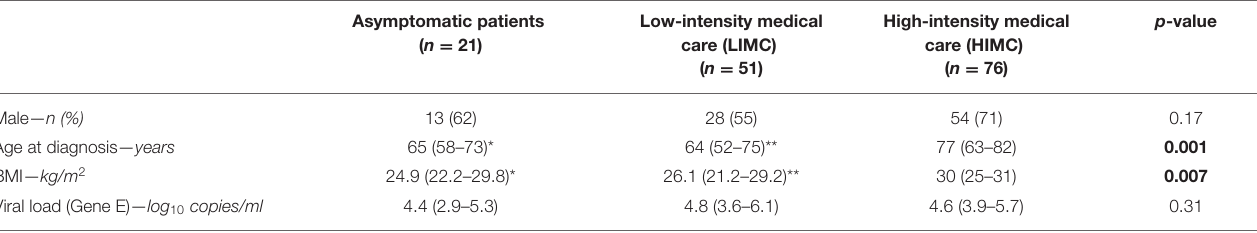
TABLE 1 | Baseline demographics and viral load of SARS-CoV-2 positive asymptomatic patients and hospitalized patients for SARS-CoV-2 related infection categorized in low (LIMC) and high (HIMC) intensity medical care. Asymptomatic patients ( n =